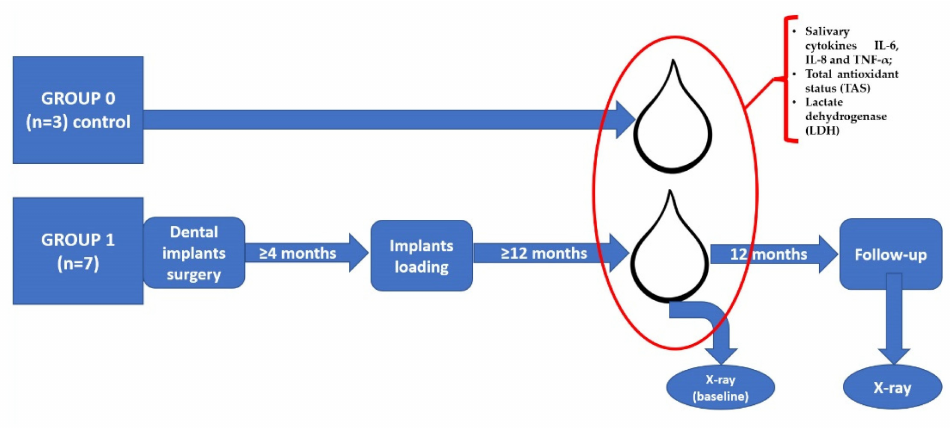
Figure 1. Pilot study